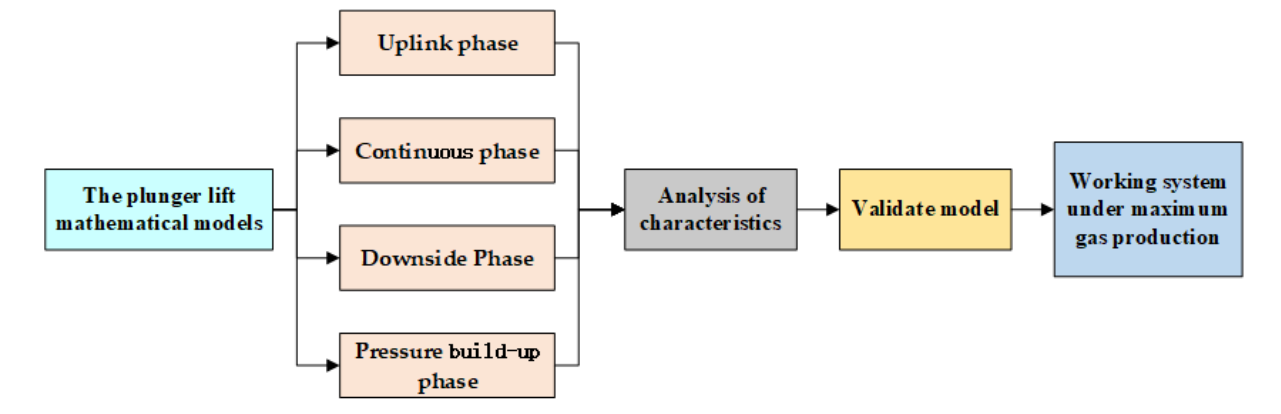
Figure 2. The workflow diagram.